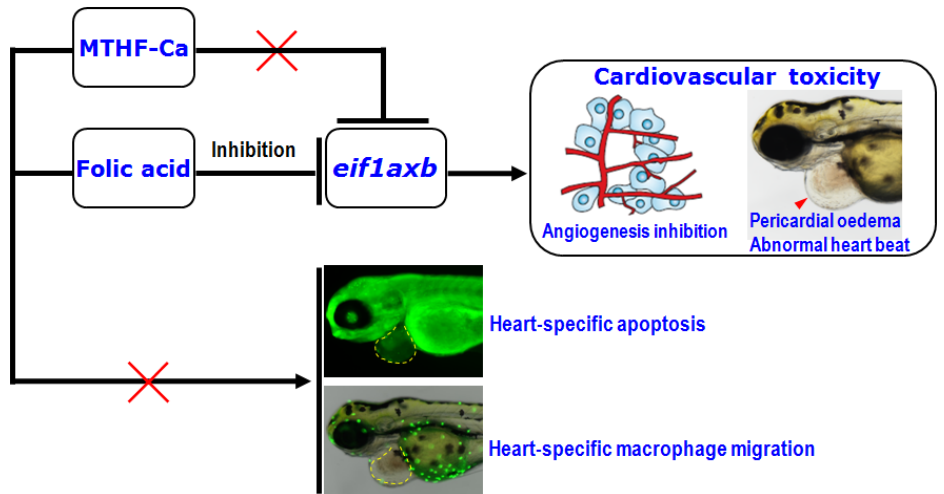
Figure 6. A putative molecular mechanism of cardiovascular toxicity in excessive supplementation of folic acid. This is a schematic illustration to demonstrate that excessive FA treatment has cardiovascular toxicity and lead to angiogenesis inhibition in zebrafish, but not apoptosis and macrophage migration in the heart. Downregulation of an essential eukaryotic translation initiation factor ( eif1axb in zebrafish) by FA may explain the molecular mechanism of cardiovascular toxicity. No adverse effects of MTHF-Ca is